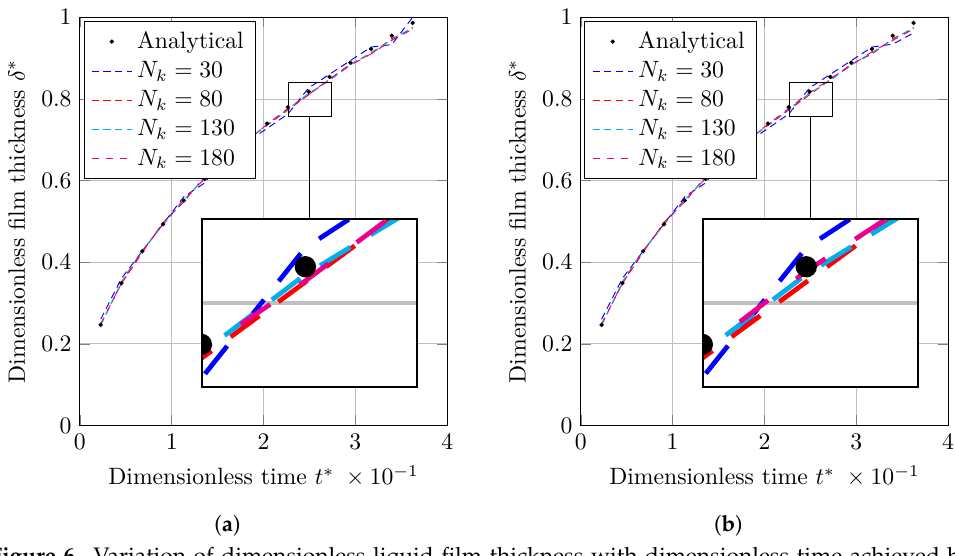
Figure 6. Variation of dimensionless liquid film thickness with dimensionless time achieved by ( a ) VOF and ( b ) CLSVOF for condensation by heat conduction study case. In Figure 7, the investigation on computational time study is demonstrated as dashed lines. As shown in this figure, VOF delivers faster computation compared to CLSVOF.